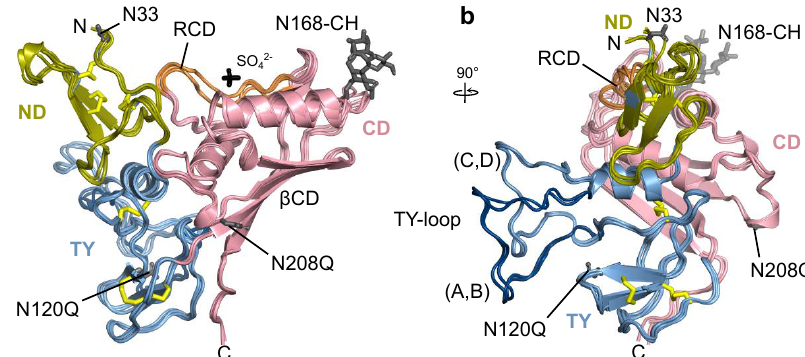
Figure 3. Superposition of individual chains of Trop2 ectodomain from the asymmetric unit shown in two orientations depicting ( a ) triangular domain arrangement, and ( b ) TY-loop protruding from the subunit. Chains are shown in ribbon representation with color-coding corresponding to individual domains (ND in olive, TY in light blue, CD in pink). Disulfide bonds, carbohydrate residues (CH), and sulfate ion (SO 42− ) are shown as yellow, grey, and black sticks, respectively. Unmutated potential N-glycosylation sites (N33, N168) and mutated ones (N120Q, N208Q) are shown as grey sticks. For clarity, individual amino acid and carbohydrate residues and the sulfate ion are shown only for chain A. Ridge region within the CD (RCD) is shown in orange, and the TY-loop of chains A and B in dark blue. Labels N and C denote N- and C-termini, respectively.